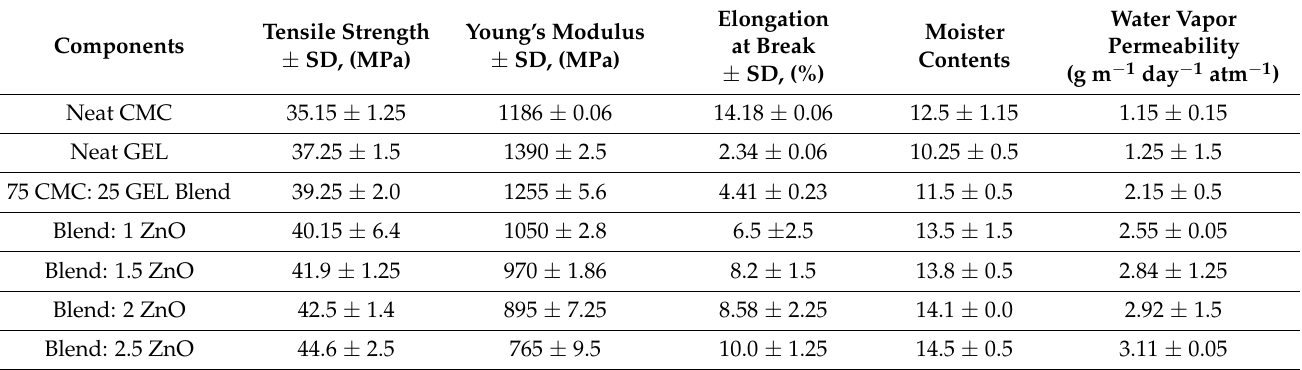
Table 3. Mechanical properties and Physical Data of CMC/GEL/ZnO nanocomposite